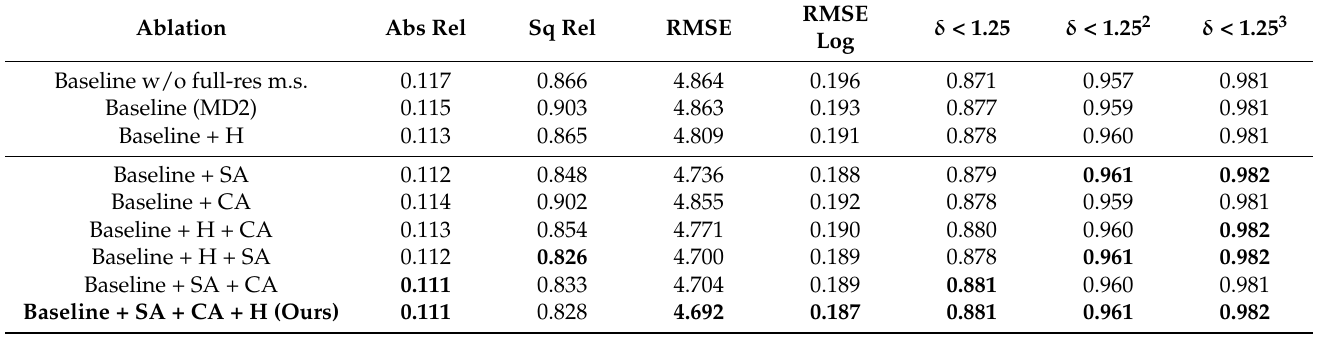
Table 4. Ablation study. Results for different variants of our model (SHdepth) with monocular training on KITTI. Best results in each category are in bold. In the first row, ‘full-res m.s.’ is the full-resolution multi-scale sampling method in Monodepth2, as shown in Figure 4. Here the baseline model is Monodepth2. In the last row, our complete SHdepth is expressed as ‘Baseline + SA + CA + H’, where SA is spatial attention, CA is channel attention, and H represents the hard attention strategy.